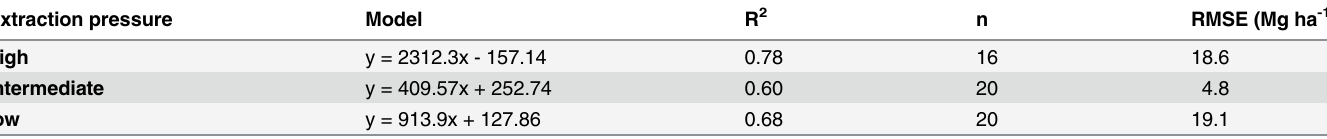
Table 1. Site-specific biomass models derived from field allometry and LiDAR metric linear regression. Extraction pressure intermediate low In the model equations, y refers to the plot-level (25 m x 25 m) biomass estimate (kg/625 m 2 ) and x to the LiDAR-derived H x CC predictor metrics, where H is plot-averaged height ( > 1.5 m) and CC is the proportion of canopy cover ( > 1.5 m in height) per plot. Root mean square error (RMSE) was reported in Mg ha -1 for ease of interpretation and n is number of 25 m x 25 m